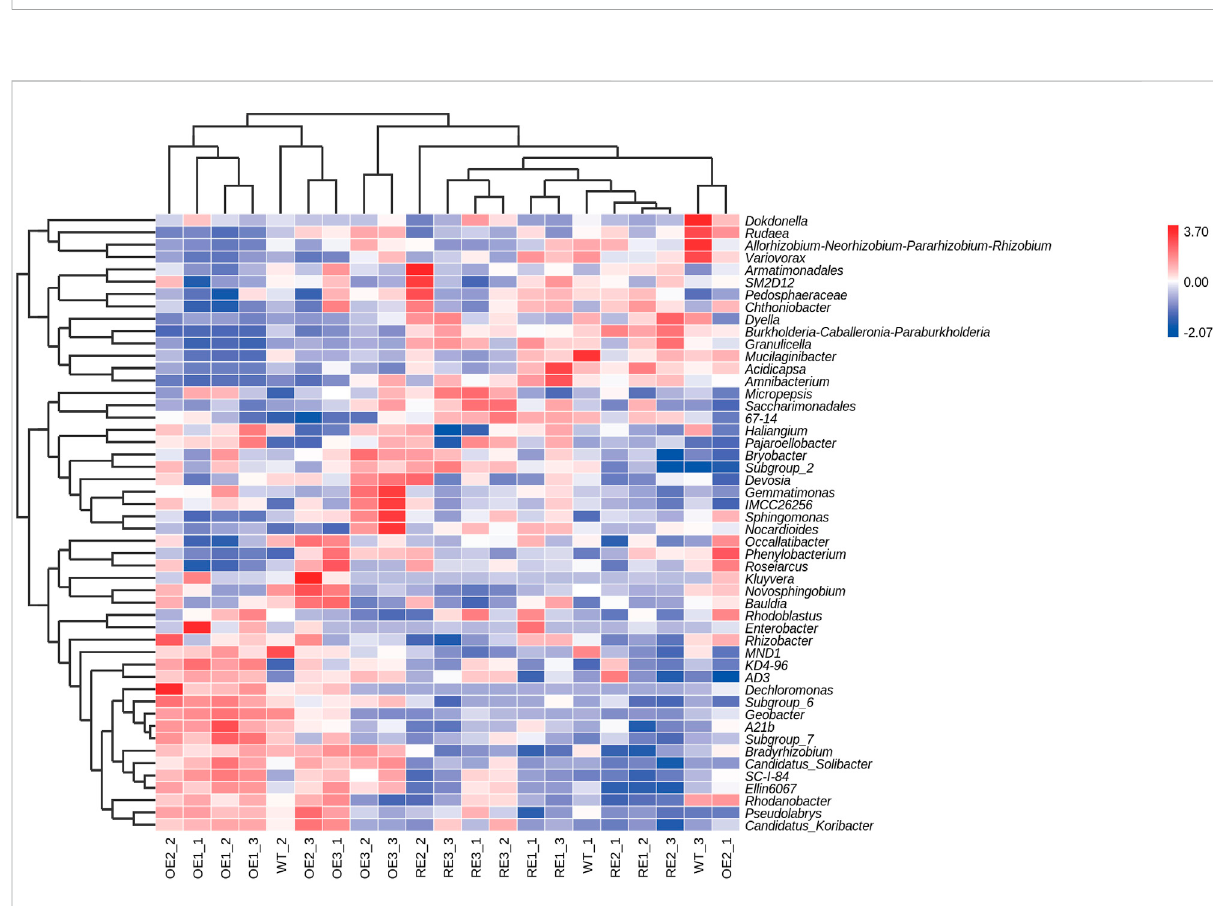
FIGURE 5 Abundance clustering heat map of the top 50 bacterial community genera in rhizosphere soil of the test lines.